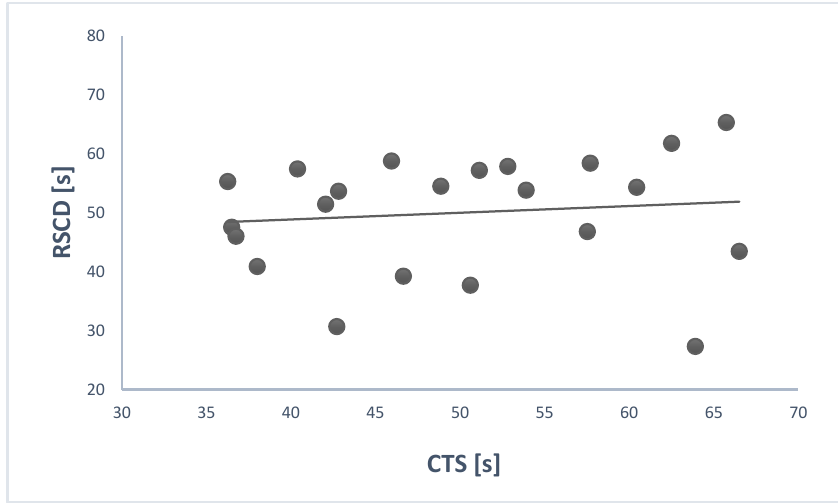
Figure 4. Correlation between the total times taken in the CST and the RSCD. The total time taken in the CST was not significantly different from the total time taken in the RSCD (46.80 ± 1.85 s and 82.36 ± 4.47 s, respectively; T = 115). The times were not significantly different regarding distance either: 0–15 m (3.34 ± 0.15 s and 5.74 ± 0.36 s, respectively; T = 124) and 15–30 m (3.34 ± 0.14 s and 5.96 ± 0.40 s, respectively; T = 122).